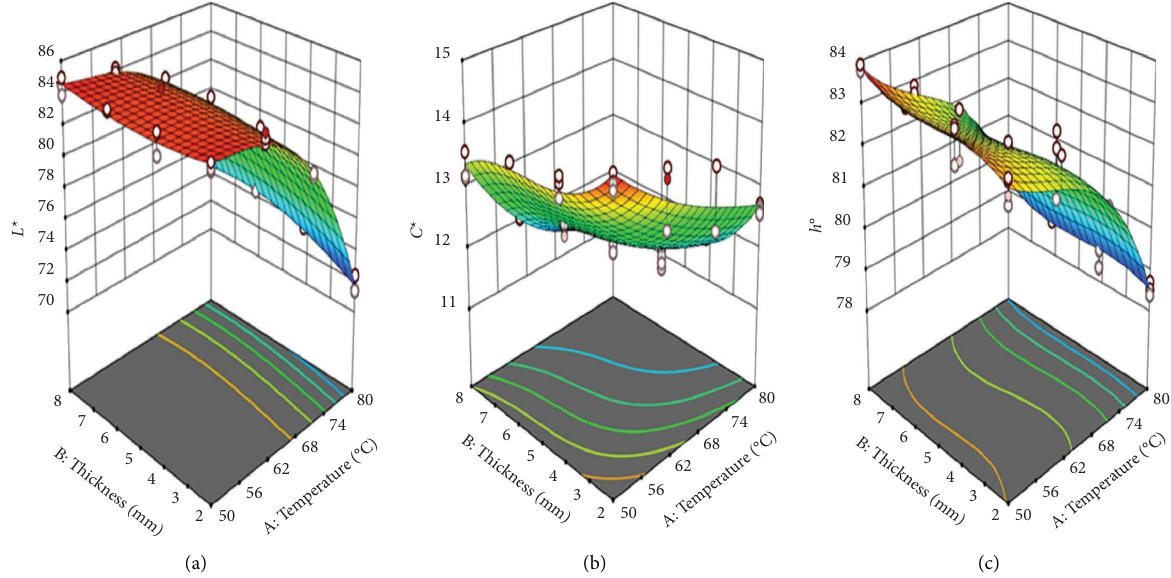
Figure 1: Infuence of tray-drying conditions on (a) L ∗ , (b) C ∗ , and (c) h o value of green banana